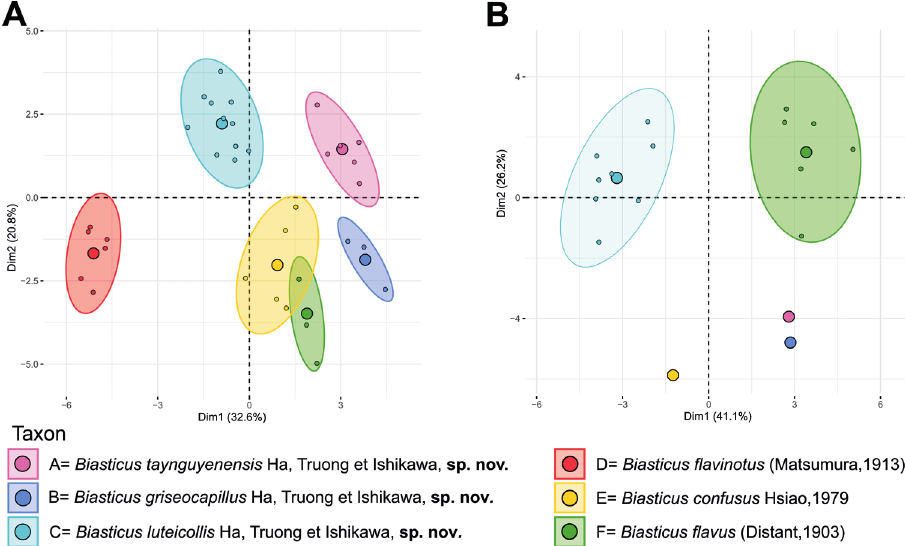
Figure 11. 2D PCA-plots from morphological dataset of the female adults ( A ) and male adults ( B ) of Biasticus collected from Vietnam and its surrounding